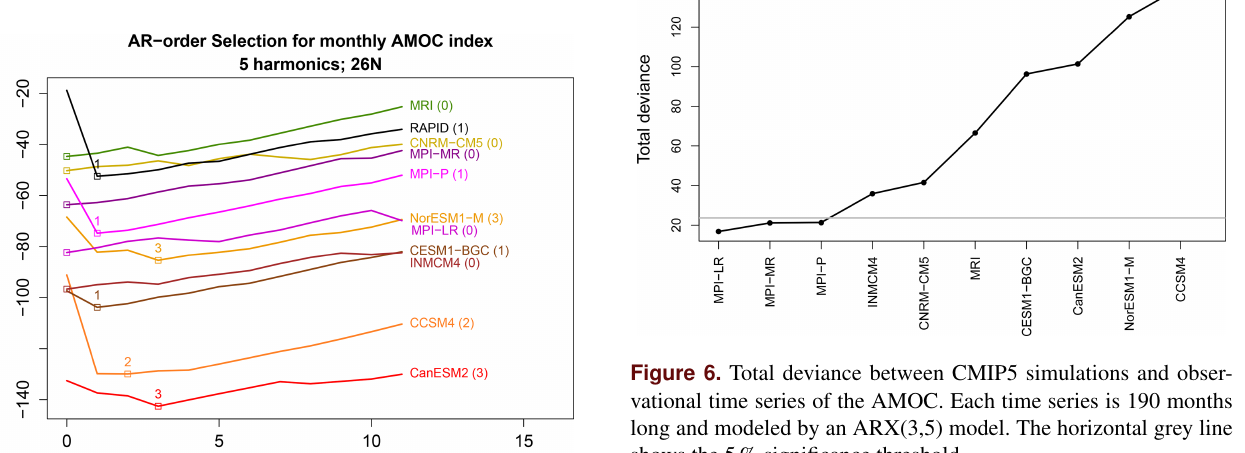
Figure 3. The AICm for fitting time series from the CanEMS2 model to ARX models of the form (3), as a function of the order of the AR process p ( x axis) and the number of annual harmonics H ( y axis). The ARX model with the smallest AICm is indicated by a dot and is labeled.